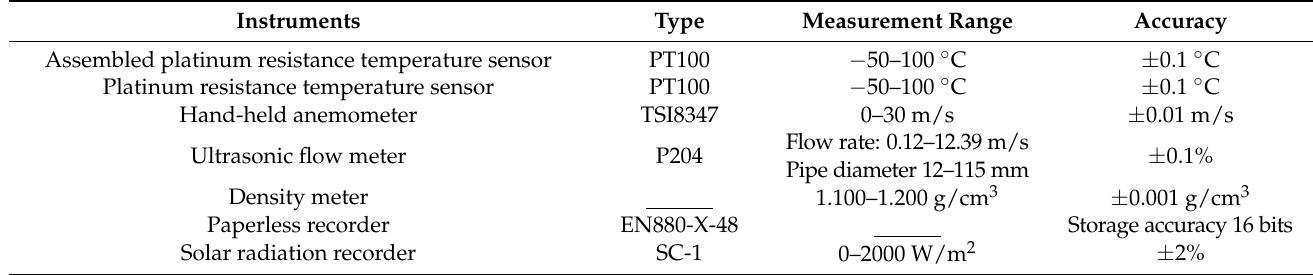
Table 3. The measurement parameters of test